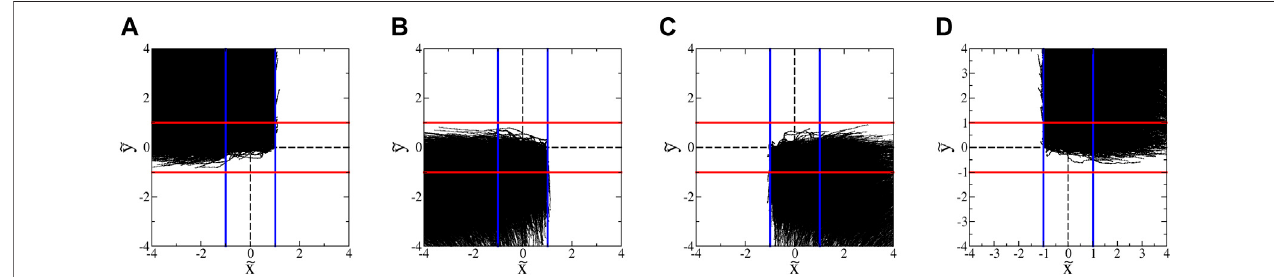
FIGURE8| Trajectories ofeuglenainhyperbolic fl owwith A =1.8s − 1 .(These dataexclude trajectories withclassicrun-and-tumble eventsduring atrajectory.) The blueandredlinesshowtheinward-andoutward-blockingSwIMedges,respectively. (A) Alltrajectoriesthatenterfromthetopandleavetotheleft. (B) Alltrajectoriesthat enter from the bottom and leave to the left. (C) All trajectories that enter from the bottom and leave to the right. (D) All trajectories that enter from the top and leave to the right.